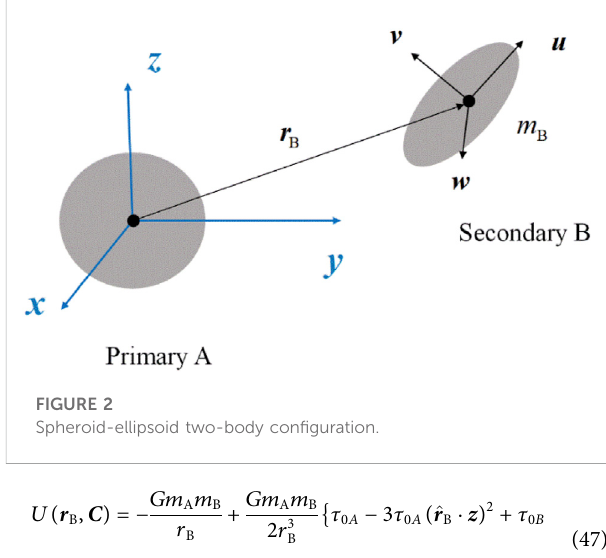
FIGURE 2 Spheroid-ellipsoid two-body con fi